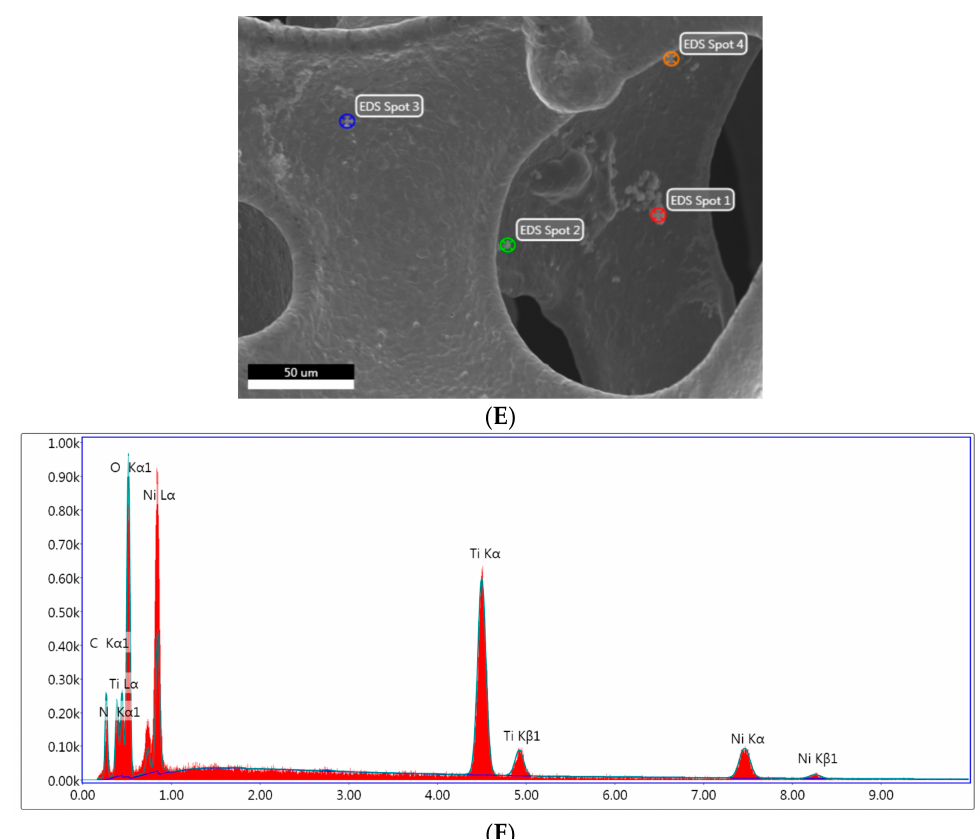
Figure 8. The morphology of TiO 2 deposited on nickel foam samples ( A – D ) and the EDX spectrum ( E , F ).